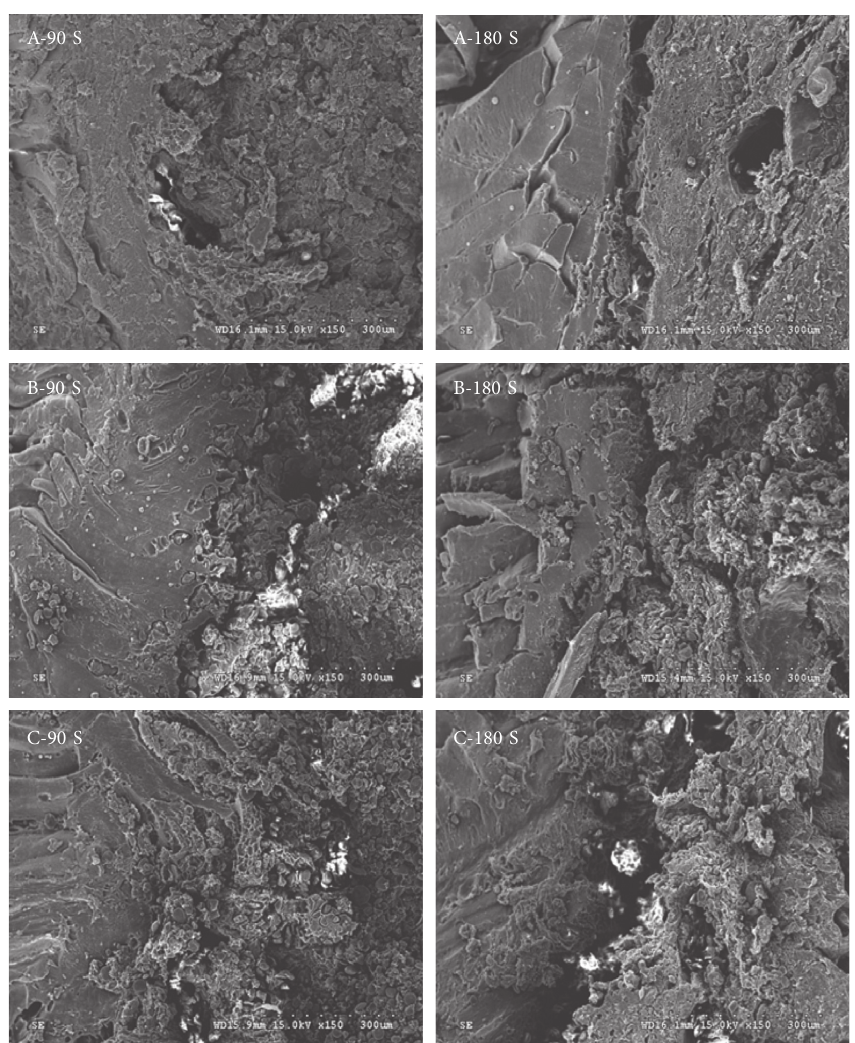
Figure 3: SEM images of BBFNs fried at different frying temperatures. (A) 160 ° C; (B) 170 ° C; (C) 180 °